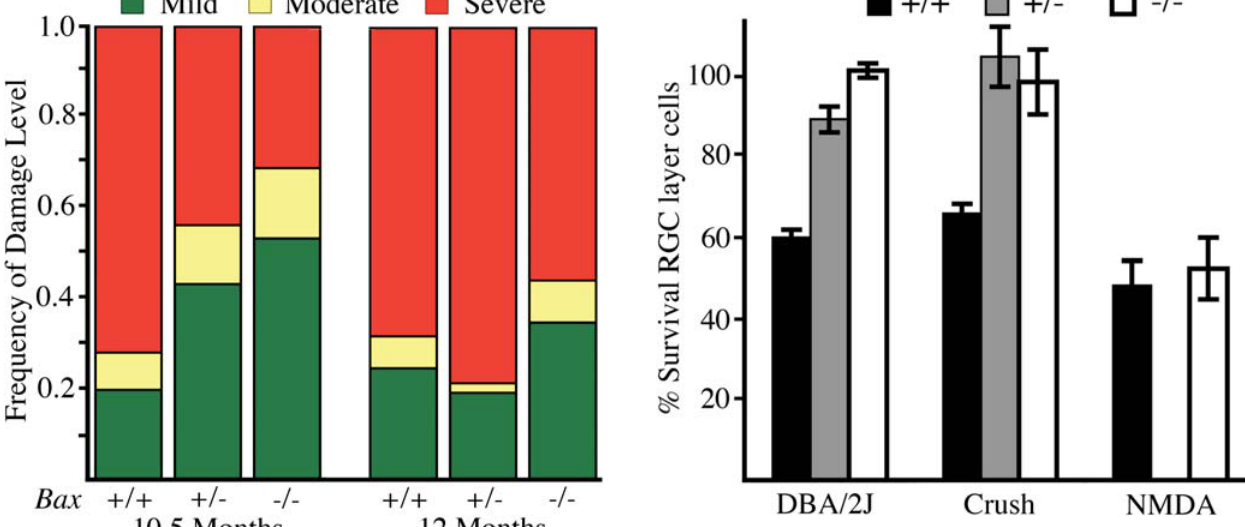
Figure 6. Mechanical Axon Insult, but Not Excitotoxicity, Induces BAX- Dependent RGC Death To help distinguish between the likely roles of mechanical axon insult and excitotoxicity in cell death induction in spontaneous glaucoma, we subjected preglaucomatous DBA/2J mice of each Bax genotype to either controlled optic nerve crush or NMDA-mediated excitotoxicity. For controlled crush and NMDA, the percent RGC survival in the manipulated eye compared to the contralateral control eye is shown. For ease of comparison, the data for glaucomatous damage are the same as shown in Figure 3. In contrast to the spontaneous glaucoma, NMDA-mediated RGC death is not dependent on BAX, as evident by the complete lack of protection from death in Bax (cid:1) / (cid:1) mice. As for the spontaneous glaucoma, RGC death induced by controlled optic nerve crush was completely dependent on BAX and prevented in both Bax +/ (cid:1) and Bax (cid:1) / (cid:1) mice. Overall, the effects of BAX in the face of spontaneous glaucoma and controlled crush were remarkably similar. DOI: